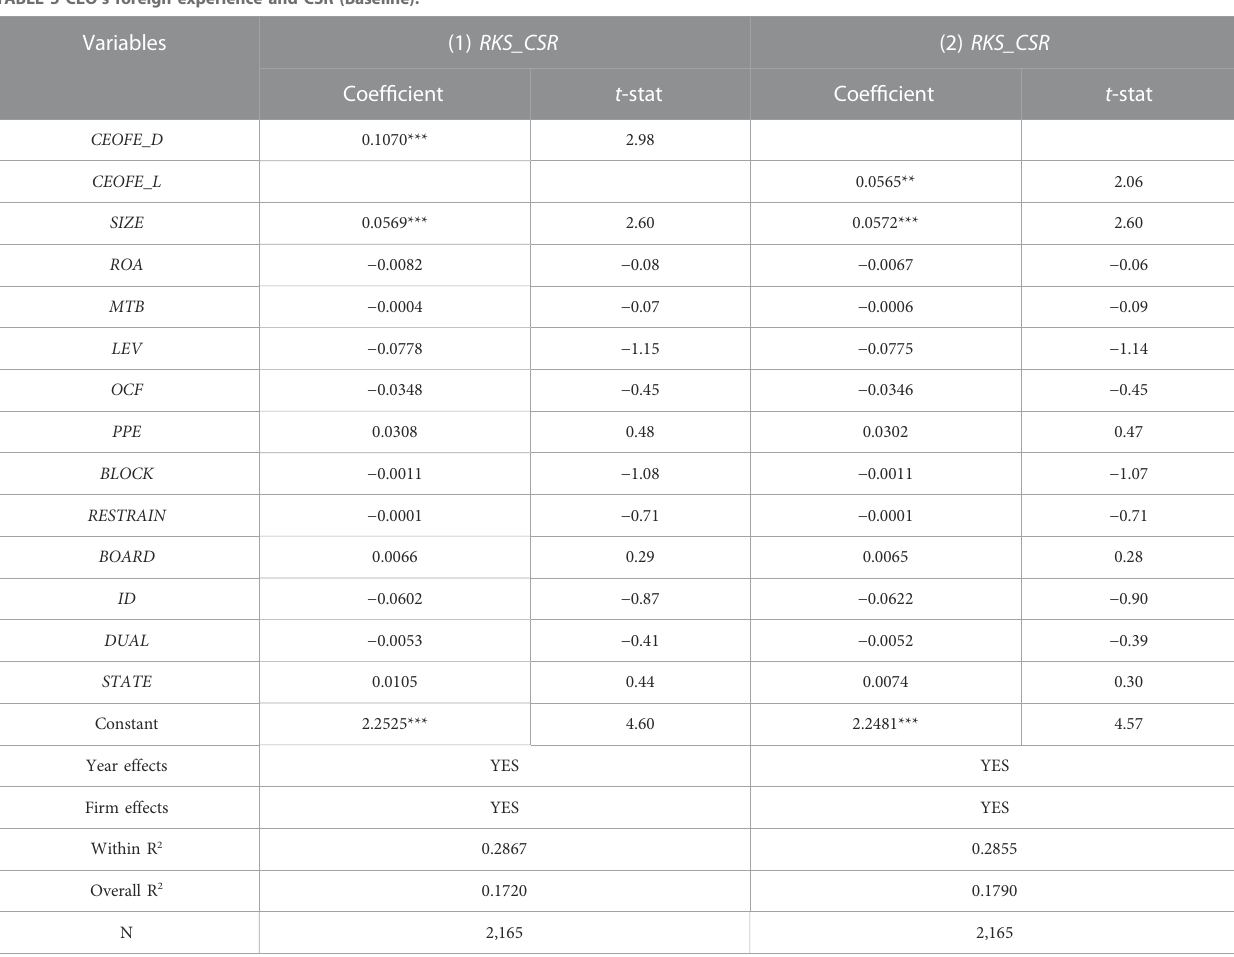
TABLE 5 CEO ’ s foreign experience and CSR (Baseline).